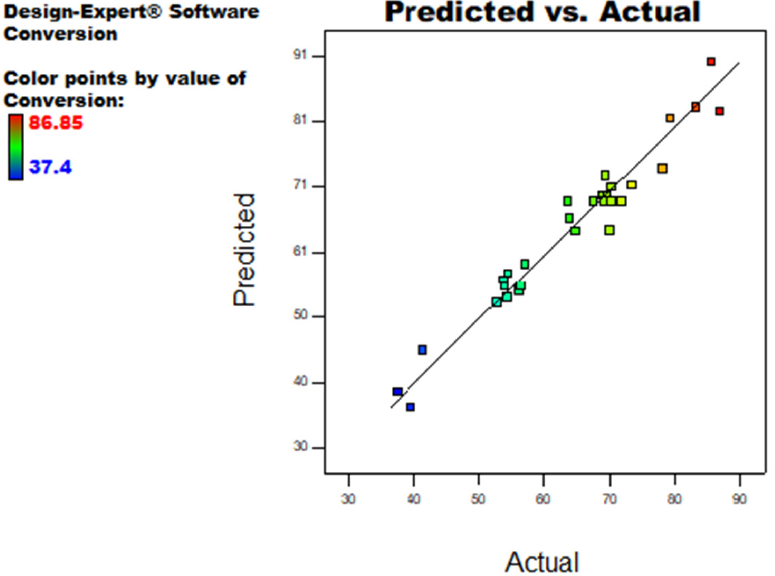
Figure 2. Performance and behavior of Equation (7) are plotted against predicted values and actual (experimental) values .